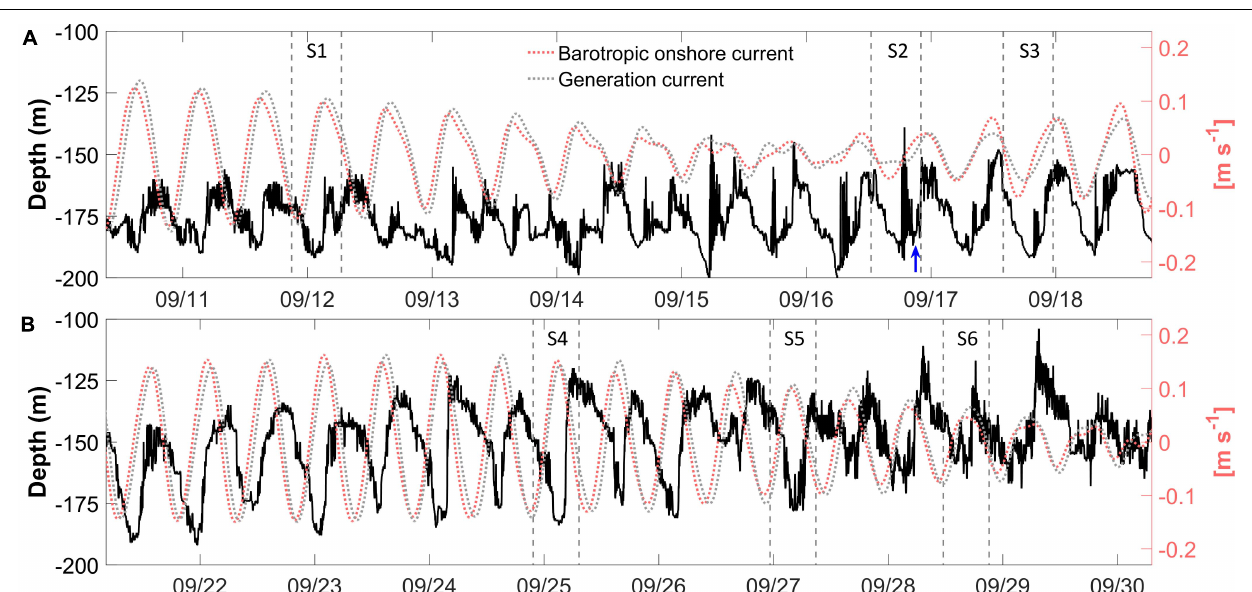
FIGURE 5 | (A,B) Time series of depth of the 20 ◦ C isotherm (left axis) together with the tidal cross-slope barotropic currents (right axis) at the time of measurement and adjusted to the generation scenario (delayed of ∼ 13 h). The ∼ 9-h segments (vertical gray dashed lines) which define the most representative features within each section of interest (S1 to S6) are also shown. In S2, the blue arrow signalizes the presence of a separation in the back of the packet of turbulent boluses (referred in